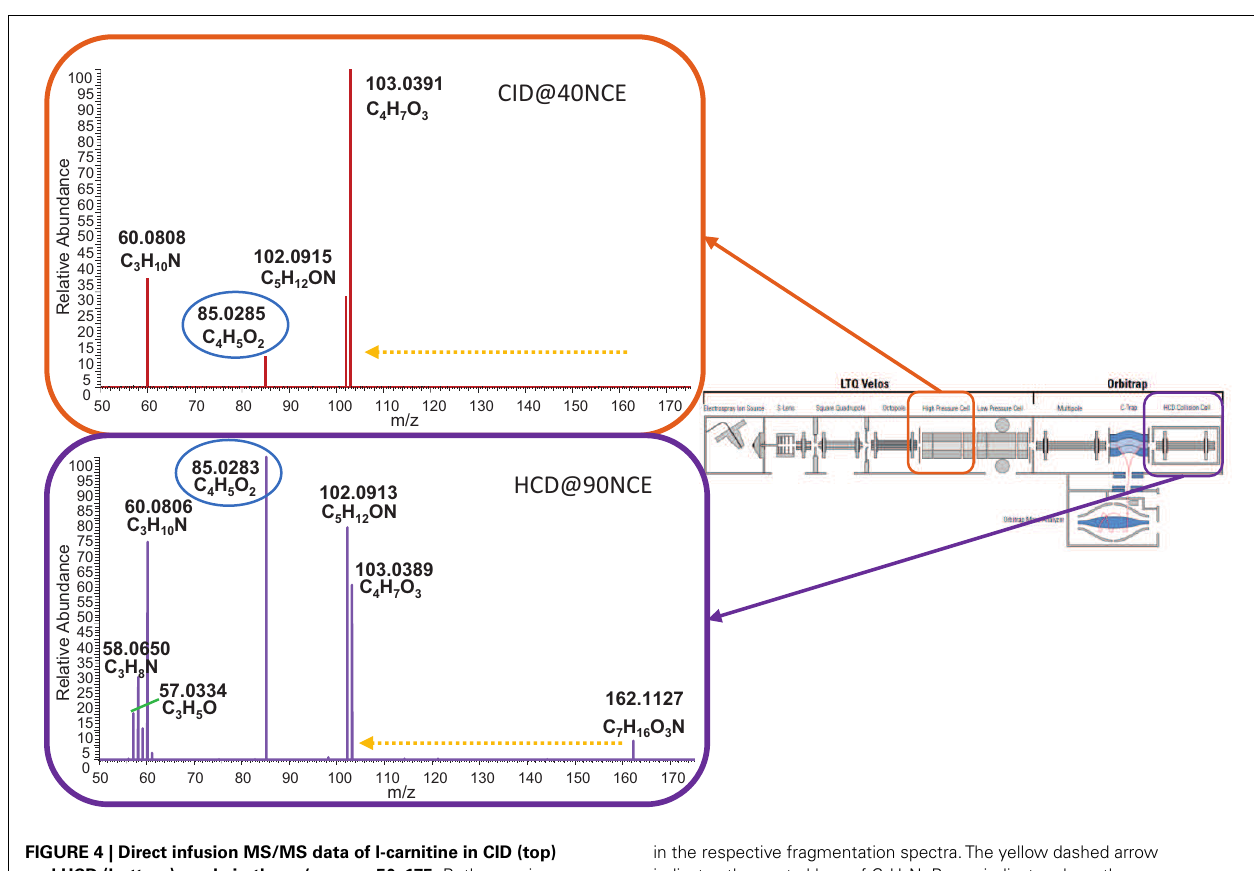
FIGURE 4 | Direct infusion MS/MS data of l-carnitine in CID (top) and HCD (bottom) mode in the m / z range 50–175 . Both energies (CID@40NCE and HCD@90NCE) represent collision energies where the key fragment C 4 H 5 O 2 , marked with a blue oval, is an abundant ion